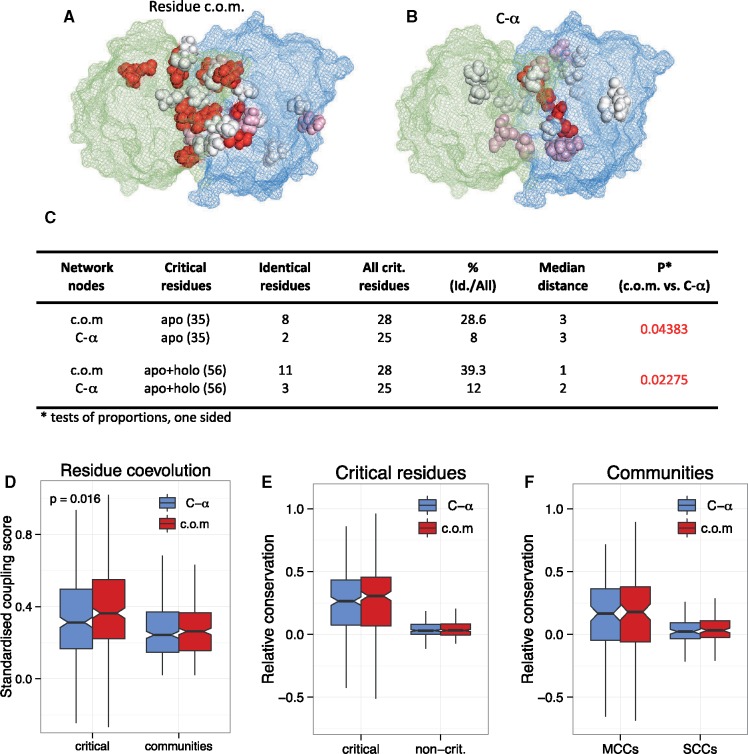
Comparison of the residue c.o.m. and C-α methods. (A) Critical residues of the HisH/HisF complex (imidazole glycerol phosphate synthase, PDB ID: 1gpw), identified with STRESS, using the residue c.o.m. method. Interior critical residues identified by STRESS are indicated by spheres. Red indicates residues that are identical to known critical residues identified by MD simulations of VanWart et al. (2012). Pink indicates residues located directly next to a known critical residue, and white indicates residues that are not in the direct proximity of a known critical residue. (B) Critical residues, identified by the default C-α method of STRESS, with similar color coding. (C) Statistical summary of the accuracy of critical residue identification in the HisH/HisF complex. The residue c.o.m. method performs better than the C-α method: a significantly higher fraction of STRESS critical residues are identical to the ones identified with MD (39% vs. 12%) by VanWart et al. (2012), both when only the critical residues of the apo structure (35 residues) or the combined set of apo + holo residues (56 residues) were used (one-sided tests of proportions). (D) The analysis of evolutionary couplings between critical and community residues indicate that critical residues are much more likely to coevolve than community residues, and that the residue c.o.m. method detects stronger couplings than the C-α method (P = 0.016, Wilcoxon test). (E and F) Despite the differences seen in HisH/HisF, the conservation of the critical residues and communities identified by the residue c.o.m. method is not higher than with the C-α method (Wilcoxon tests).